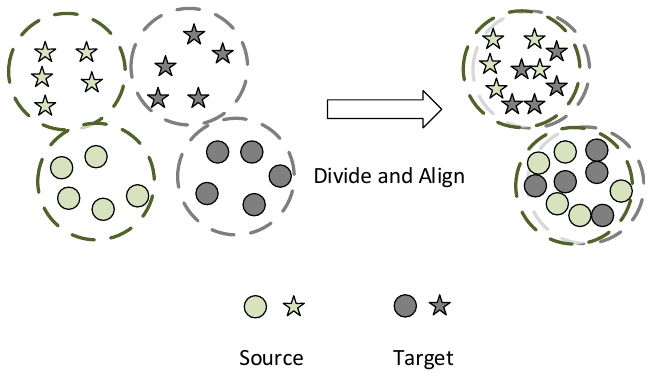
Figure 4. Schematic diagram of Domain